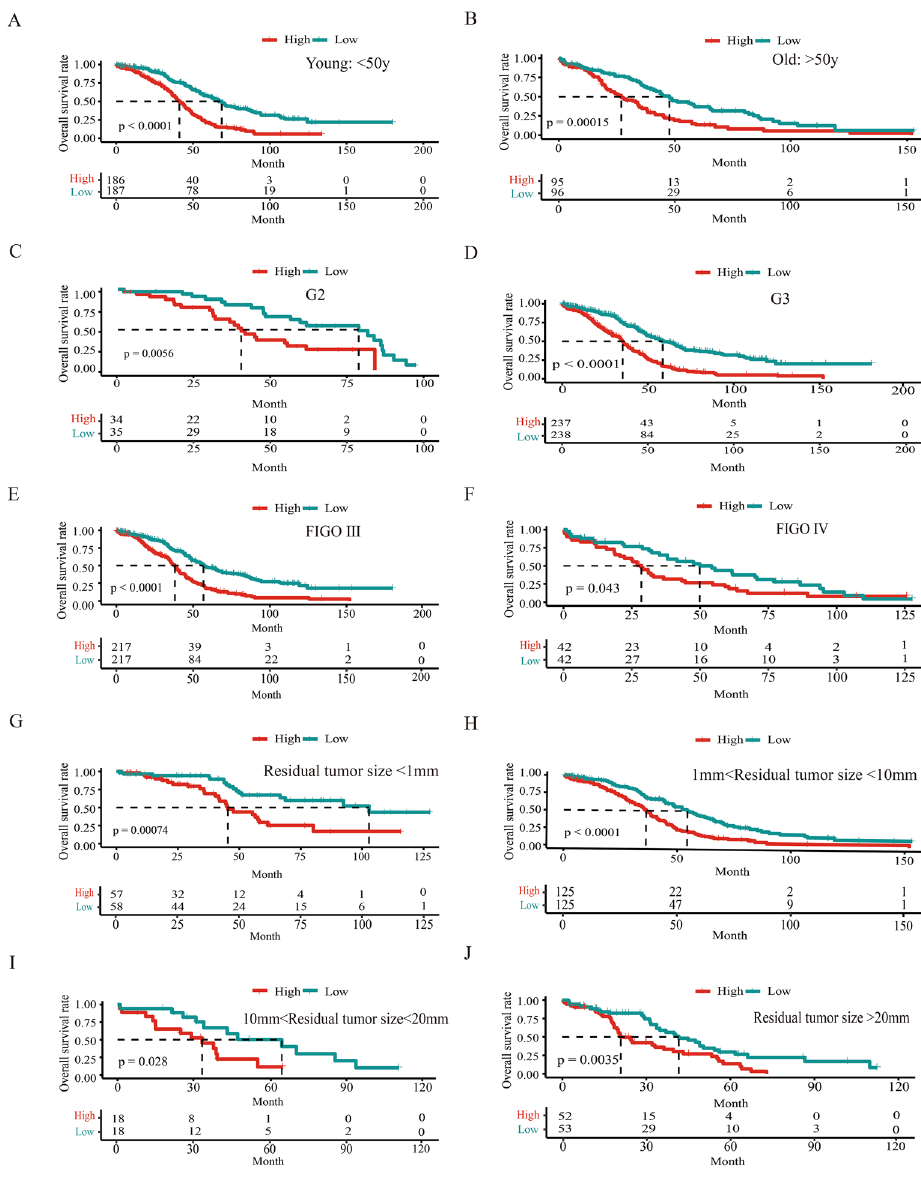
Figure 4. Construct a stratified analysis based on age ( A , B ), grade ( C , D ), FIGO grade ( E , F ) and residual resection status ( G – J ) to analyze the association between the TFs related prognostic signature and overall